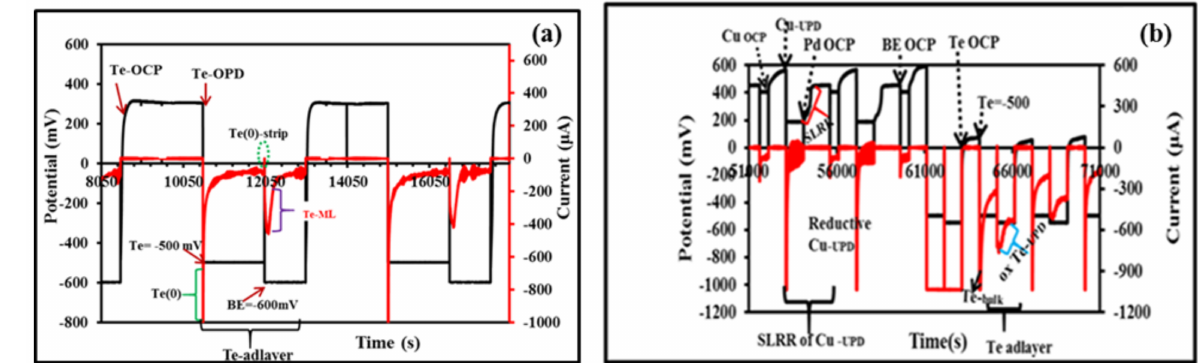
Figure 2. Potential–current–time plot generated for Te ( a ) and PdTe ( b ) over two E-ALD